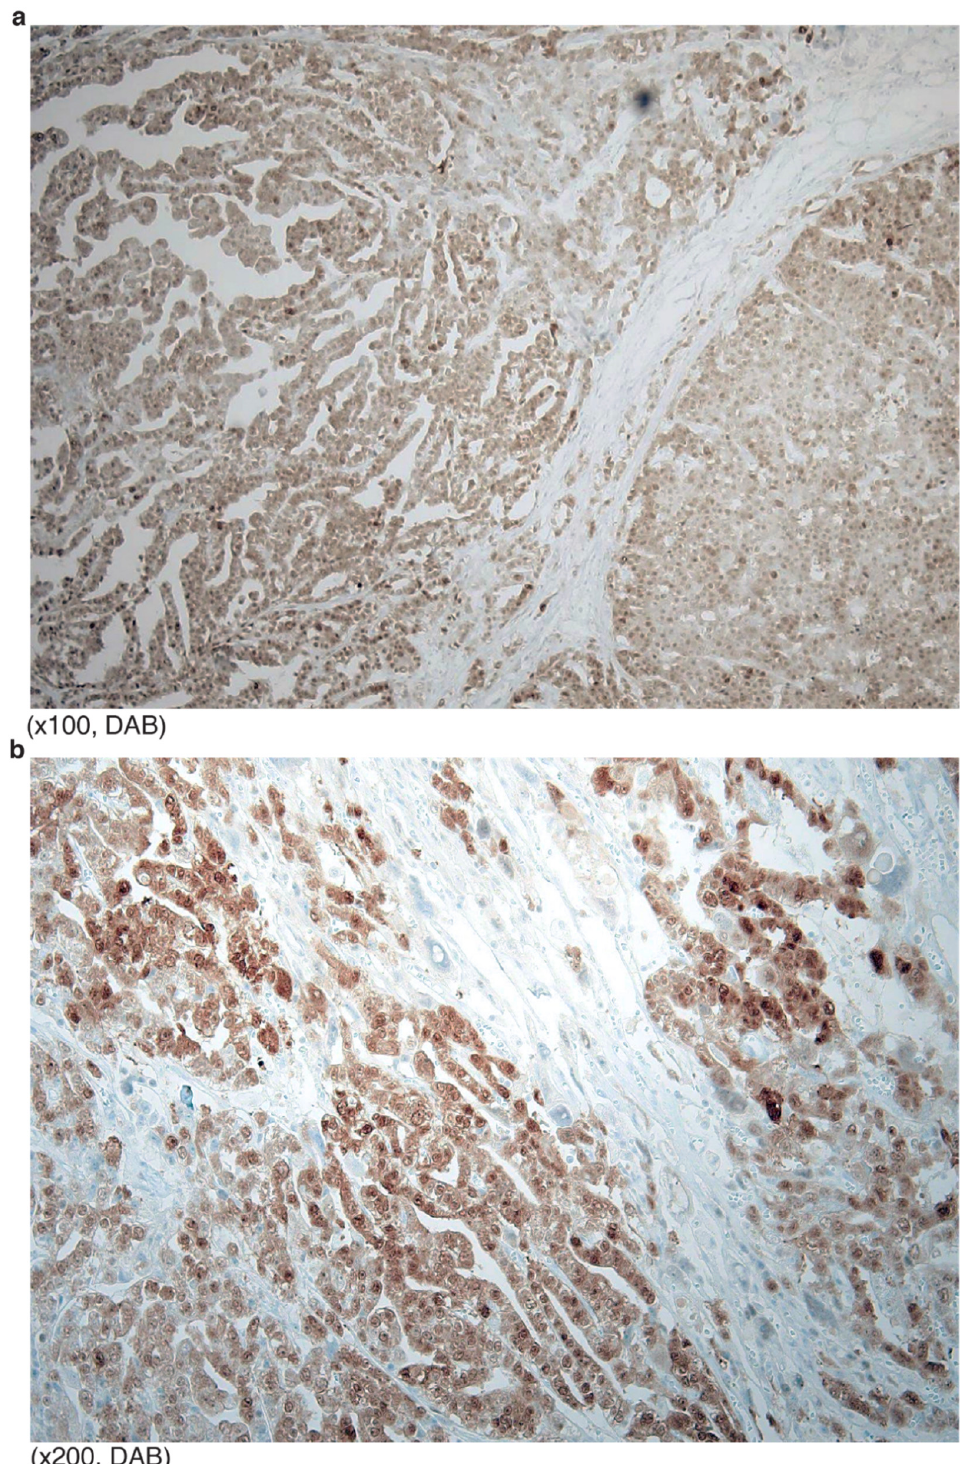
Figure 5. Cytoplasmic staining patterns of p53 from tumors of TP53 mutations near NLS: ( a ) Heavy signals look like missense mutation, but careful observation revealed cytoplasmic staining (L289F fs*57); ( b ) predominant cytoplasmic staining of p53 (R342*).